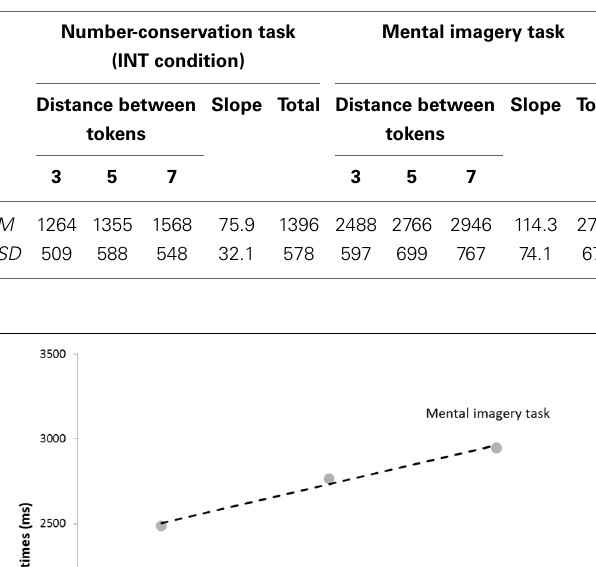
Table 1b | The mean response times, mean slopes of the best-fitting line and standard deviations for the three differences in distance between the tokens in the two rows in the INT condition of the number-conservation and mental imagery task.